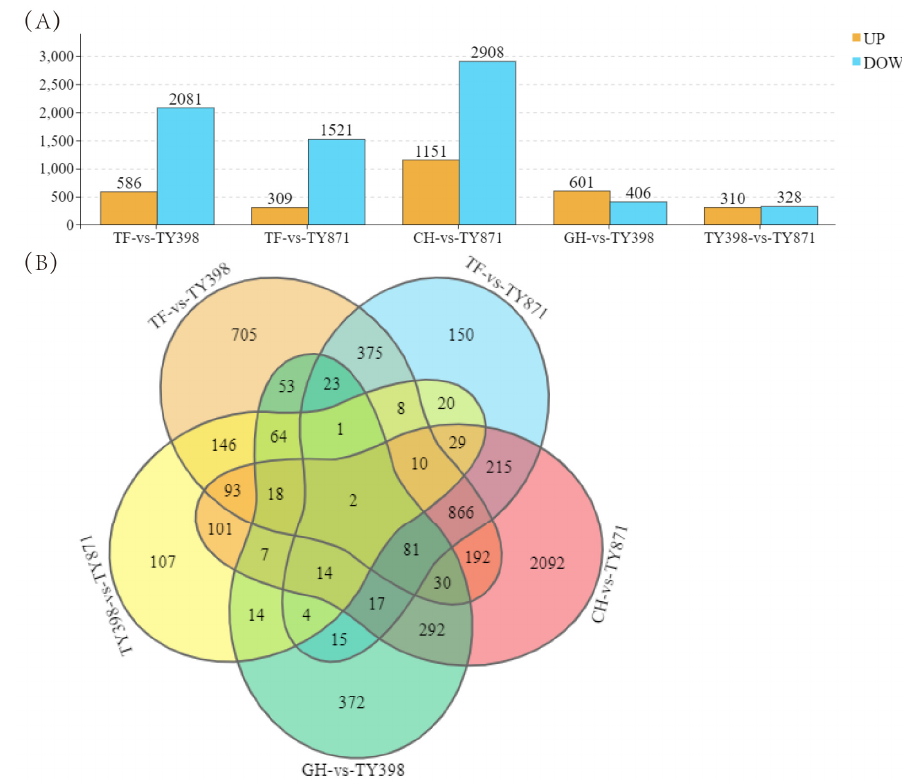
Figure 2. Differentially expressed genes analysis. ( A ) the number of differentially expressed genes in five sets (CH-vs.-TY871, TF-vs.-TY398, TF-vs.-TY871, GH-vs.-TY398, TY398-vs.-TY871); ( B ) Venn diagrams of the DEGs.